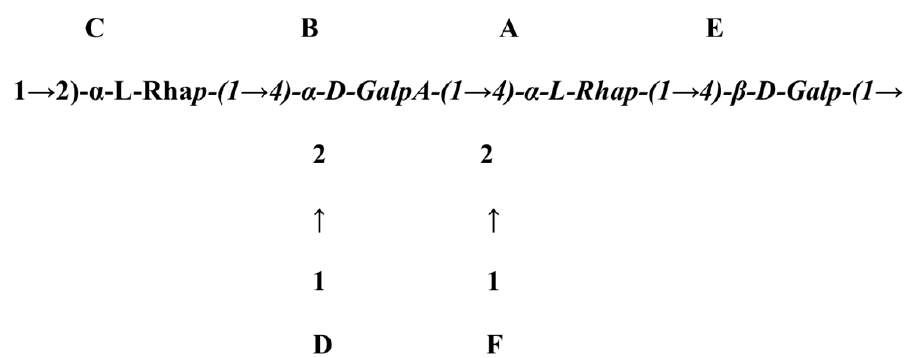
Figure 2. Representation of the proposed structure of gum katira polysaccharide Reprinted/adapted with permission from [60].